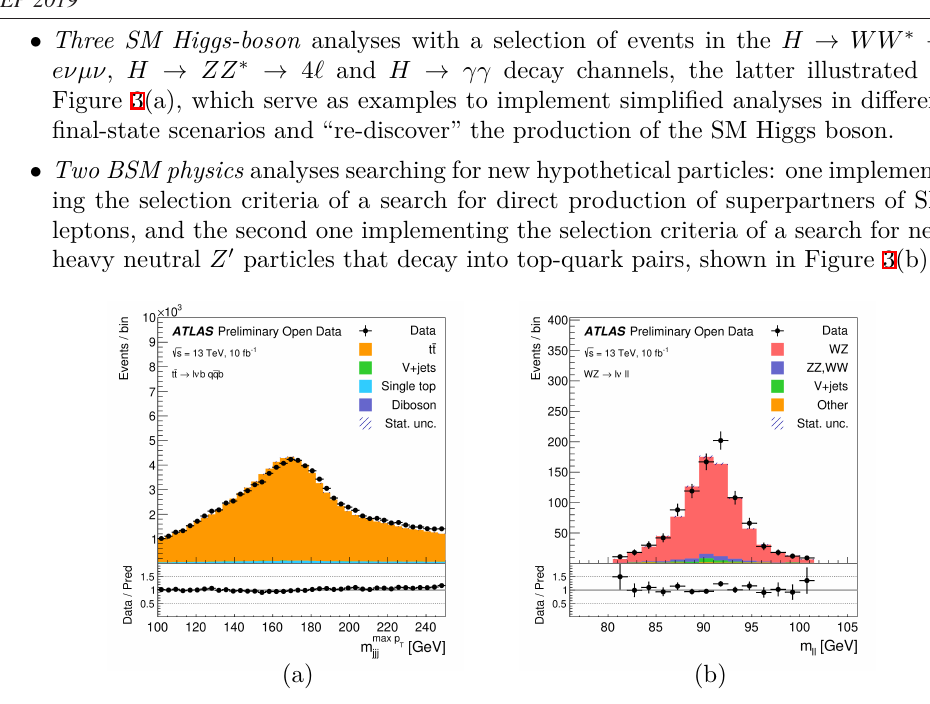
Figure 2. Comparison between data and MC prediction for the distribution of (a) the invari- ant mass of the three-jets combination with the highest vector p T in the t (cid:22) t ! W + W (cid:0) b (cid:22) b ! ′ ℓ(cid:23)q (cid:22) q b (cid:22) b selection, and (b) the invariant mass of the reconstructed Z-boson candidate in the